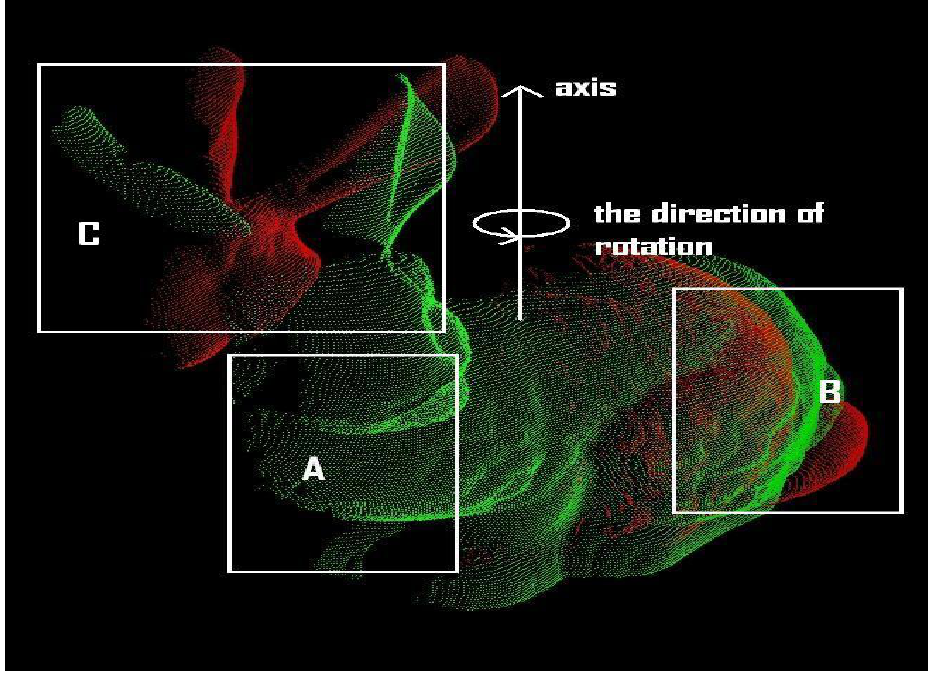
Figure 11. Schematic outline of the convergence tests with the Stanford bunny. The axis and the direction of the initial rotations for the convergence tests are presented. The red point cloud, the bunny090, is rotated around the axis either to or against the direction of rotation in the picture.